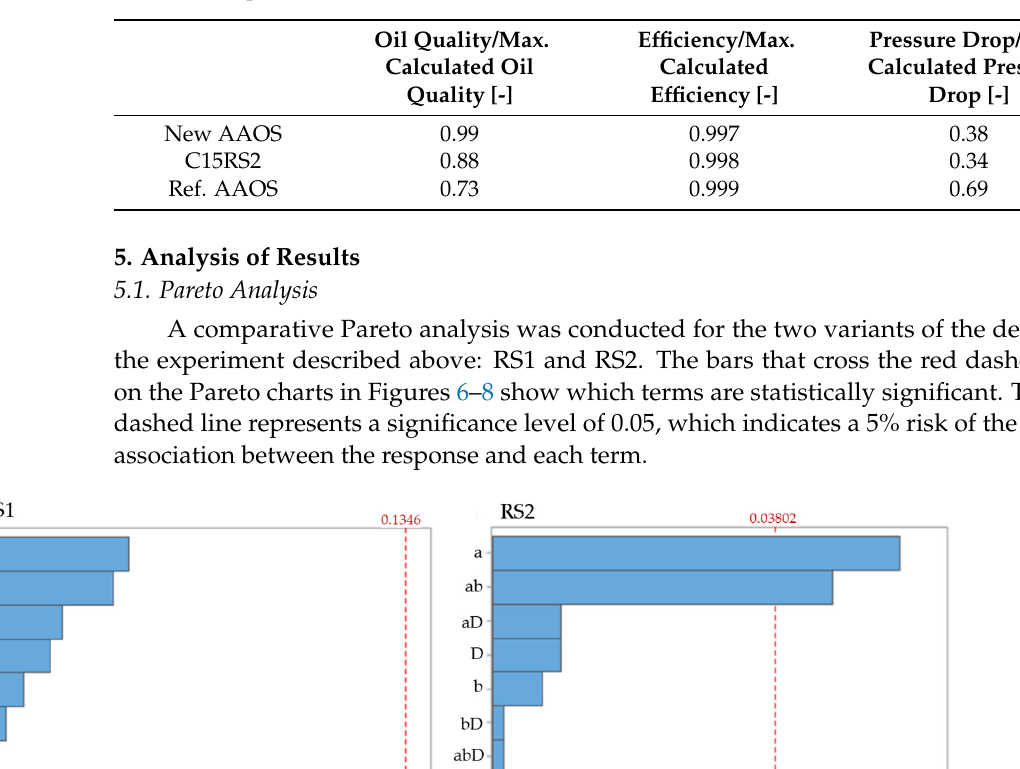
Table 5. Comparison results (results/max. value from DOEs).